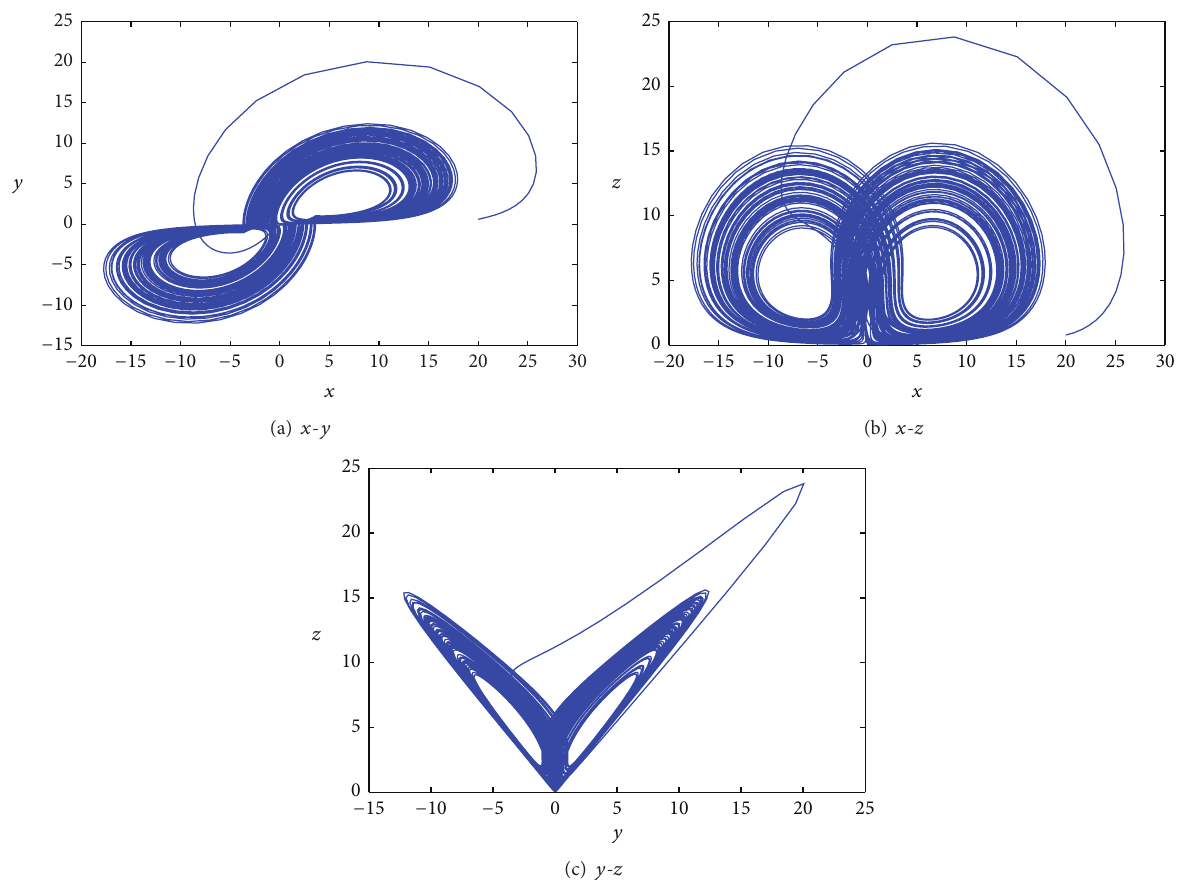
Figure 1: Phase trajectories of fractional-order chaotic system